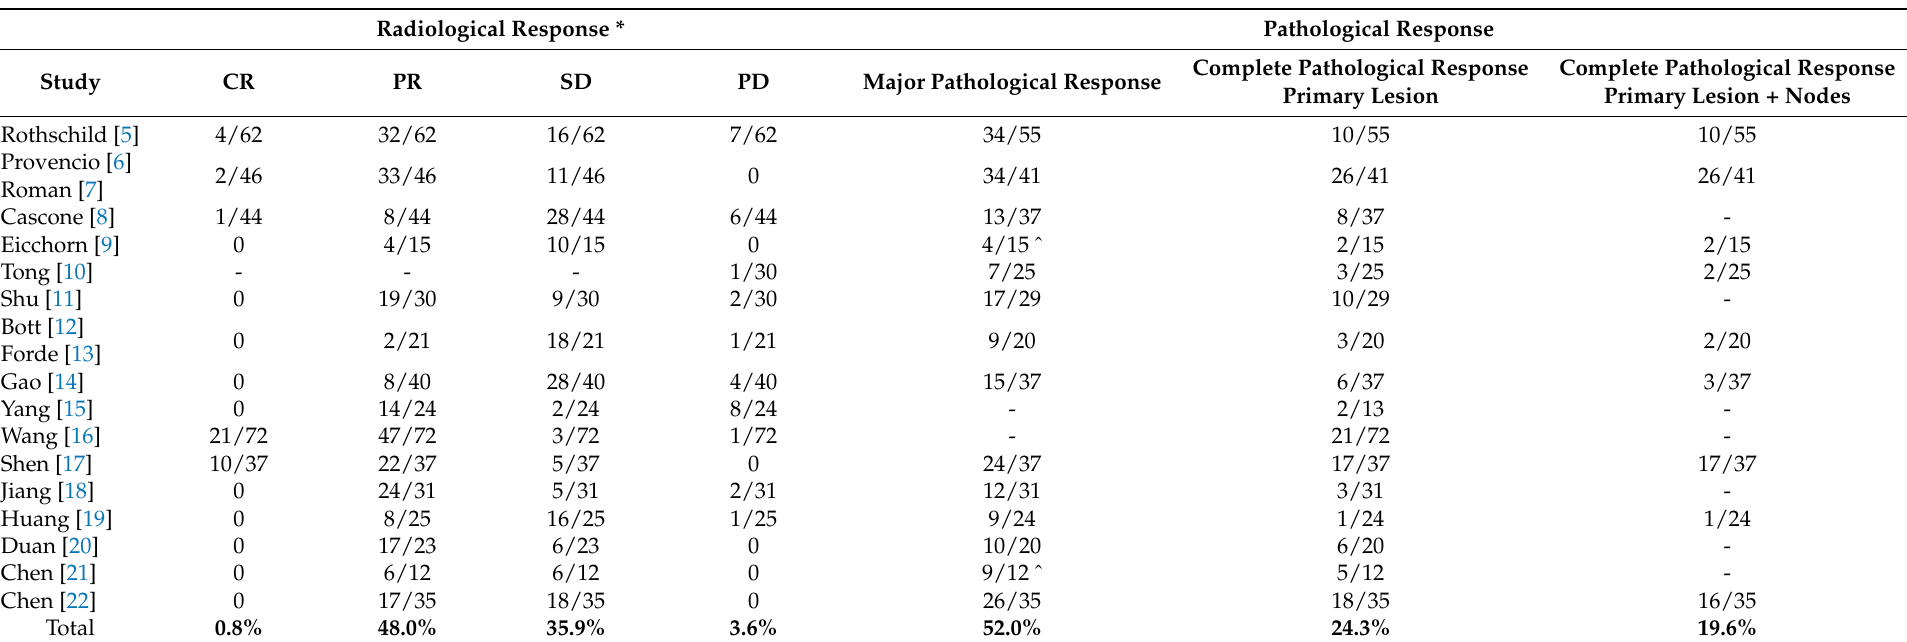
Table 4. A summary of radiological and pathological responses after neoadjuvant immunotherapy for patients with resectable non-small cell lung cancer. Radiological Response